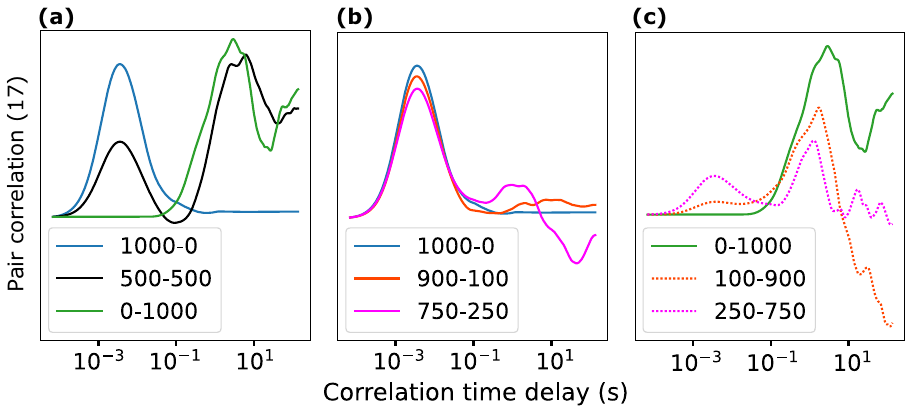
Figure 9. pCF simulated data for two coexisting molecular species. Two coexisting molecular species diffuse at 50 μm 2 /s (fast population) and 0.1 μm 2 /s (slow population) in a cubic box of 64-pixels size. Labels indicate the number of molecules in a format: fast molecules-slow molecules. The total number of molecules was kept constant across the simulations at 1000 molecules/box. ( A ) The pCF analysis shows two peaks (black curve) with correlation times delays at 3.7 ms and 950 ms corresponding to the average times required by each molecular population to travel between the two positions (17 pixels or 850 nm apart). When only one molecular population is present (blue and green curves), a single peak is detected. ( B , C ) Effect of relative populations on the amplitude of the correlation curve. If either of the two populations is less than ≈25%, the pCF analysis could not clearly separate them and the recovered correlation function tends to emphasize the largest